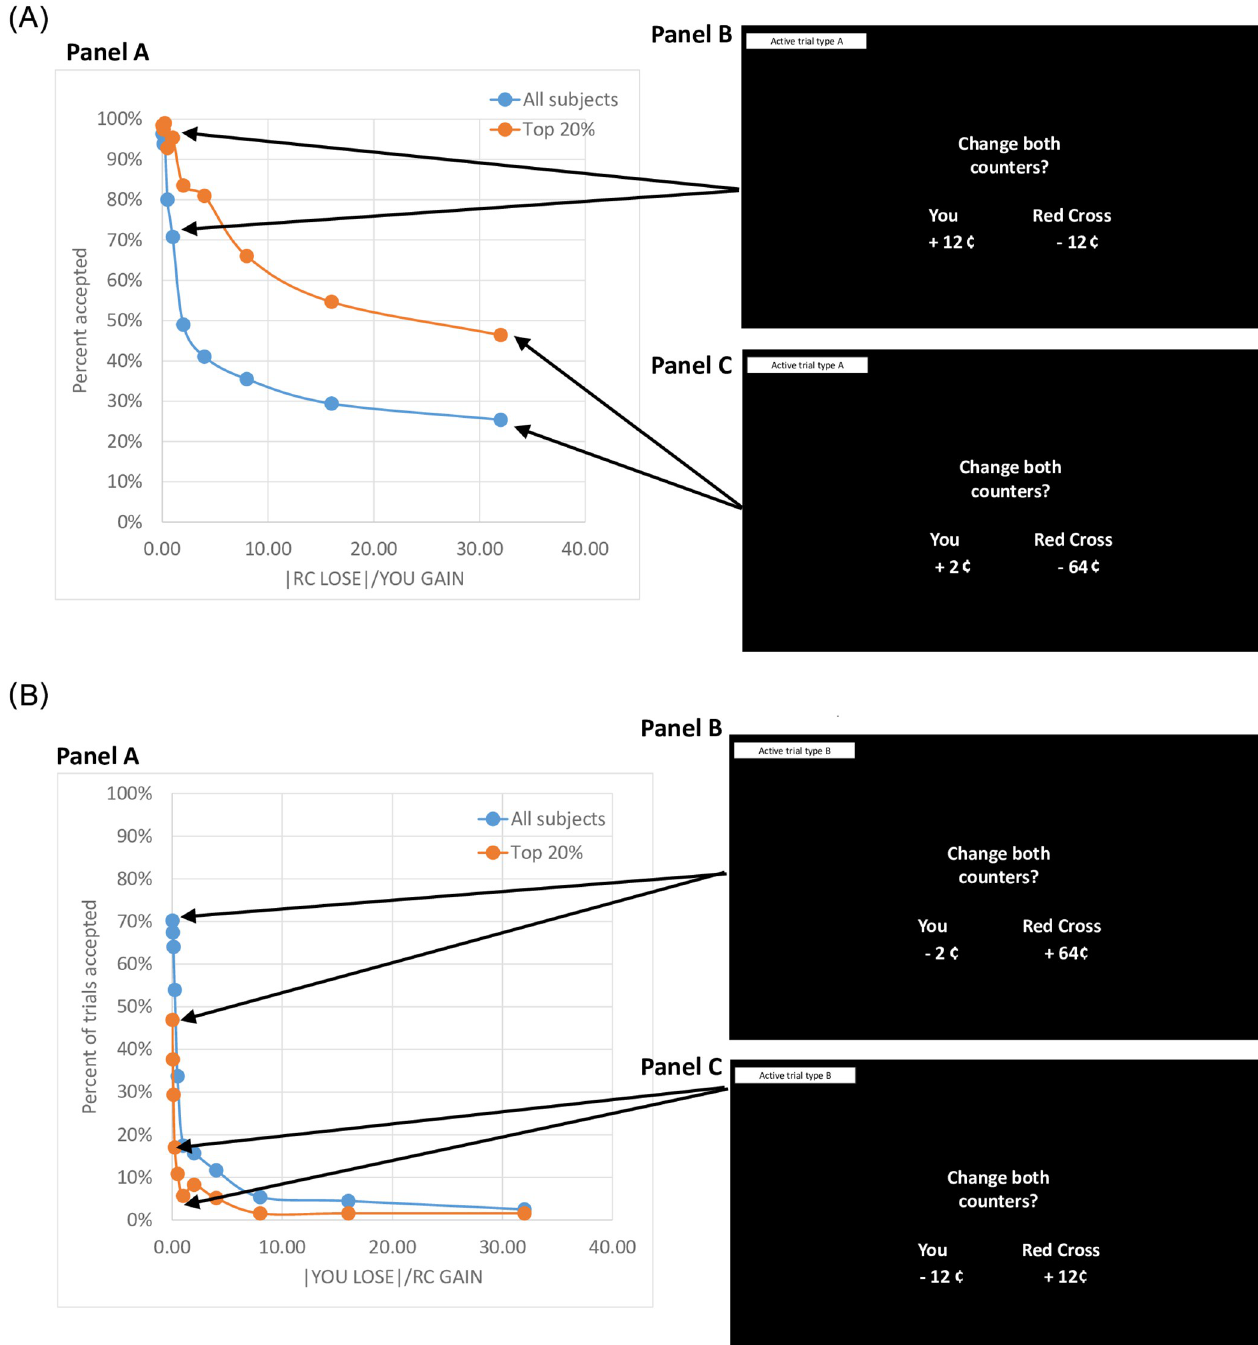
Fig 3. A. Panel A : Graphing Active Trials Type A (Red Cross loss and “You” gain trials)–Percent of trials accepted (Y-Axis) by Ratio of absolute value of Red Cross loss divided by “You” gain amount (X-Axis). Blue line indicates all subjects (n = 485 depending on the trial) and orange line represents those in the top 20% for Levenson Self-Report Psychopathy Scale Factor 1 scores (n = 97, with scores � 45). Panel B shows Active Trial Type A with a ratio = 1; arrows show that these trials were accepted 71% and 95% of the time by the full sample and high Psychopathic traits group, respectively. Panel C shows Active Trial Type A with a ratio of 32; arrows show that these trials were accepted 25% and 46% of the time by the full sample and high Levenson Factor 1 score group, respectively. Note data from Runs 1 and 2 were included in these analyses. B. Panel A : Graphing Active Trials Type B (“You” lose and Red Cross gain trials)–Percent of trials accepted (Y-Axis) by Ratio of absolute value of “You” loss divided by Red Cross gain amount. Blue line indicates all subjects (n = 485) and orange line represents those in the top 20% for Levenson Self Report Psychopathic Trait Factor 1 scores (n = 97, with scores � 45). Panel B shows Active Trial Type B with a ratio of 0.03; arrows show that these trials were accepted 70% and 47% of the time by the full sample and high Levenson Factor 1 group, respectively. Panel C shows